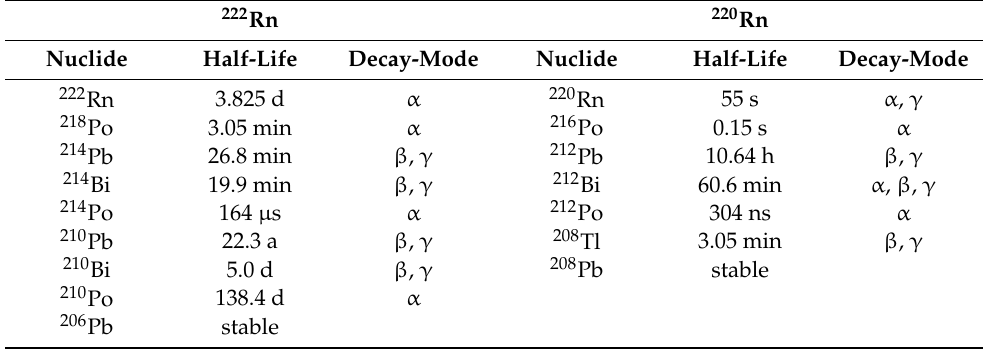
Table 1. Decay scheme of 222 Rn and 220 Rn